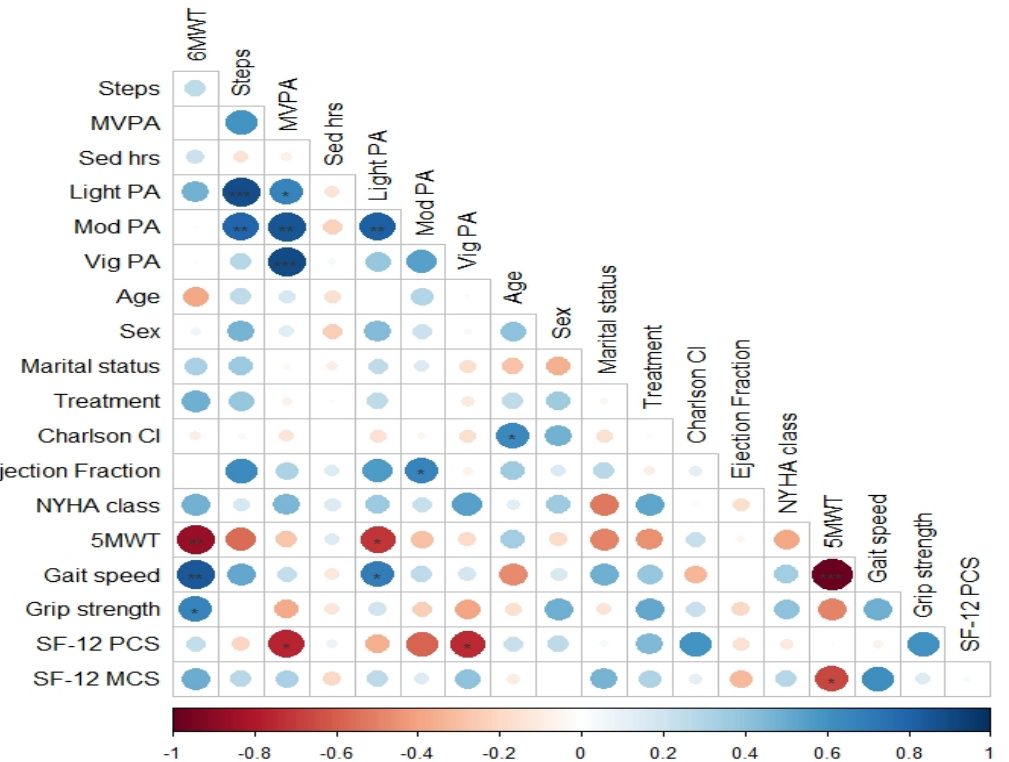
Figure 2. Correlation matrix: association between functional capacity assessments, incidental PA outcomes, and key clinical and demographic variables pre- and post-AVR. 6MWT = six-minute walk test, Steps = average steps per day, MVPA = mean vigorous physical activity, Sed hrs = sedentary hours, Light PA = light physical activity, Mod PA = moderate physical activity, Vig PA = vigorous physical activity, and 5MWT = gait speed.